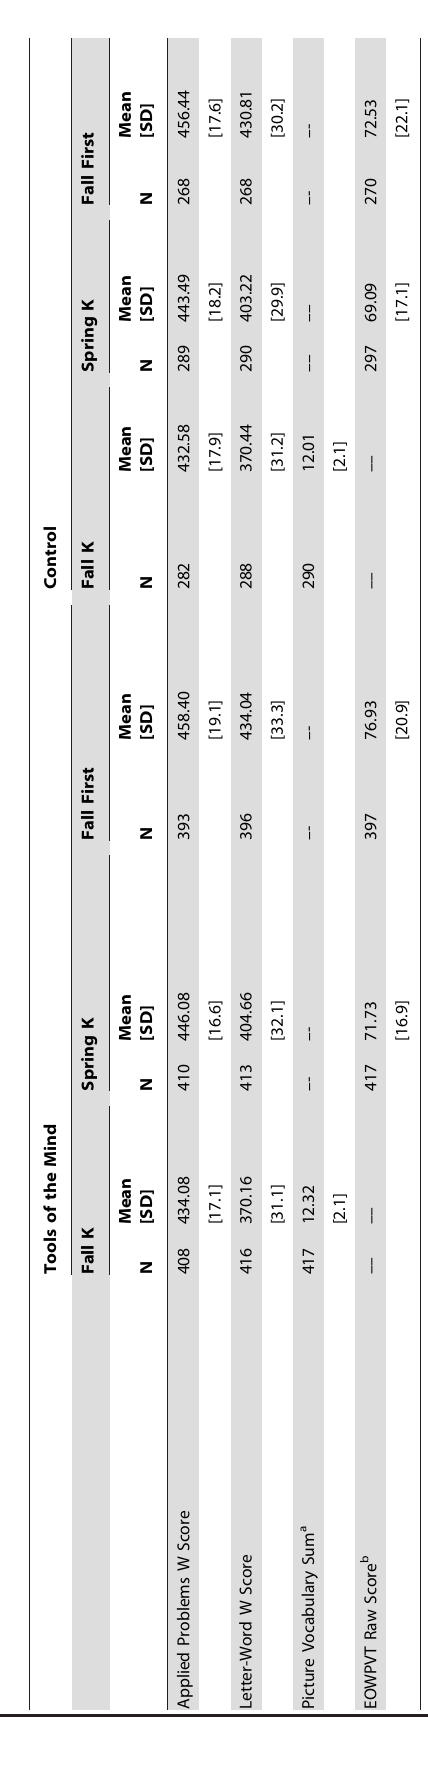
We analyzed the data using multilevel models with children nested within schools, the unit of random assignment. We bootstrapped clustered standard errors [B = 1000] to provide asymptotic refinement and more consistent estimates of standard errors [se] given that the data are hierarchically nested in a small number of clusters [N =29] and variances may be heteroskedastic [60,61]. For all analyses, treatment versus control group status was included as a binary indicator along with the pretreatment [fall] measure of the outcome variable and child-level [age, sex, parent